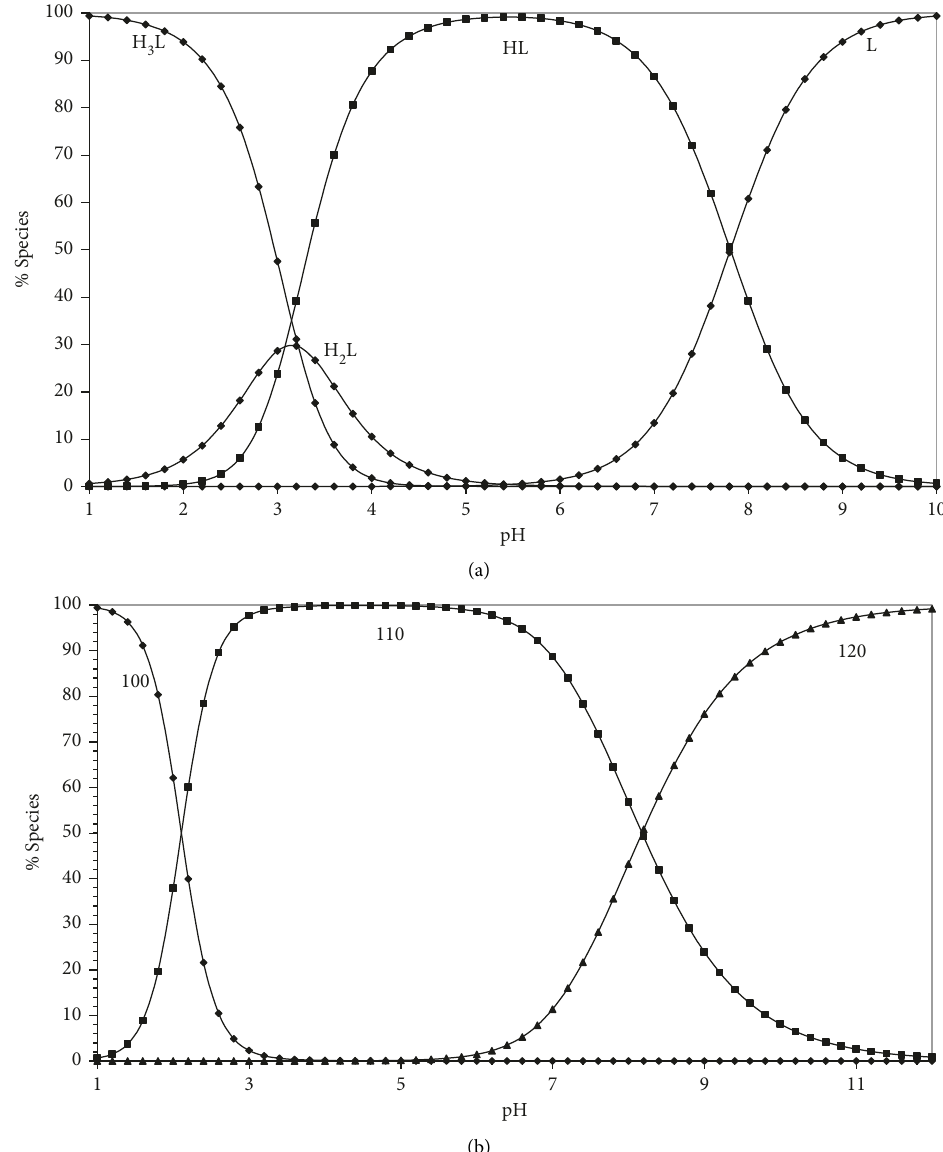
Figure 5: (a) Concentration distribution diagram of various species as a function of pH in the TSC1 system (at a concentration of TSC1 � 1.25 mM and T � 25 ° C). (b) Concentration distribution diagram of various species as a function of pH in the Cd-TSC1